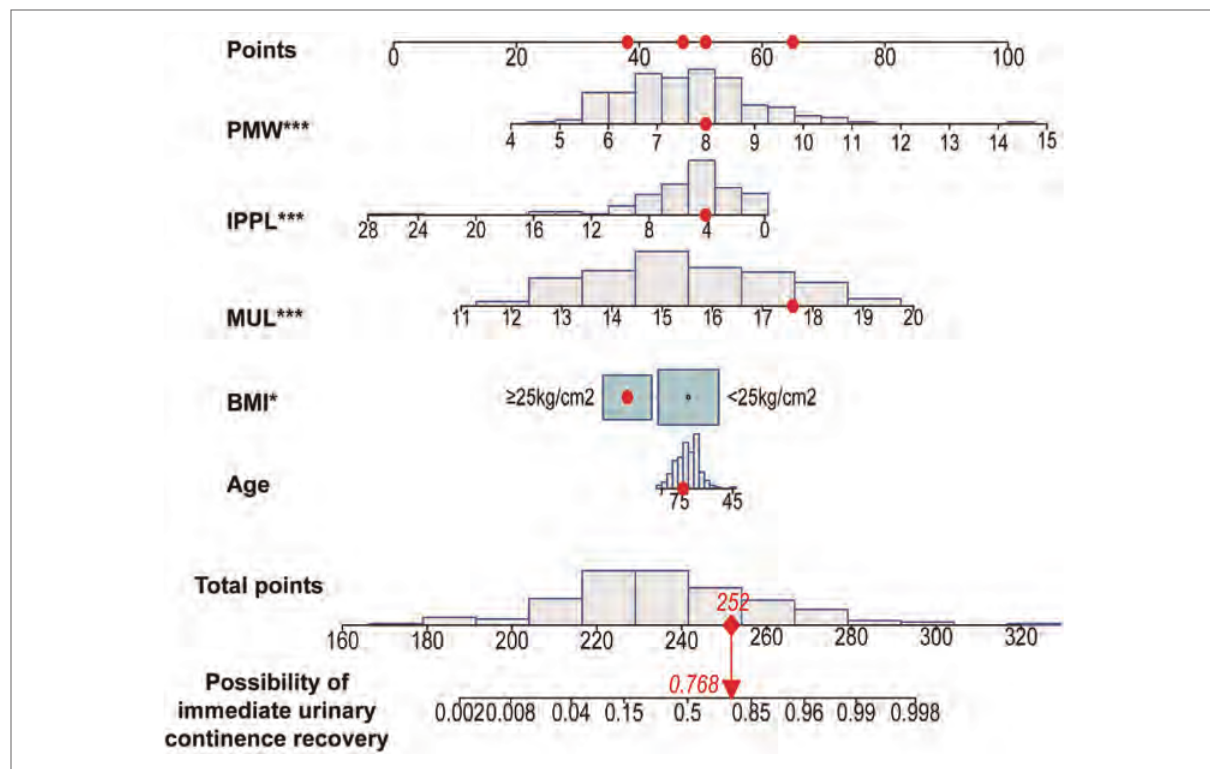
FIGURE 5 Developed immediate urinary continence recovery nomogram. Note: The immediate urinary continence recovery nomogram was developed in the cohort, with age, body mass index (BMI), the membranous urethral length (MUL), puborectalis muscle width (PMW) and the intravesical prostatic protrusion length (IPPL) were incorporated. * p <0.05; ** p <0.01; *** p <0.001. BMI, body mass index; IPPL, Intravesical prostatic protrusion length; MUL, membranous urethral length; PMW, Puborectalis muscle width.